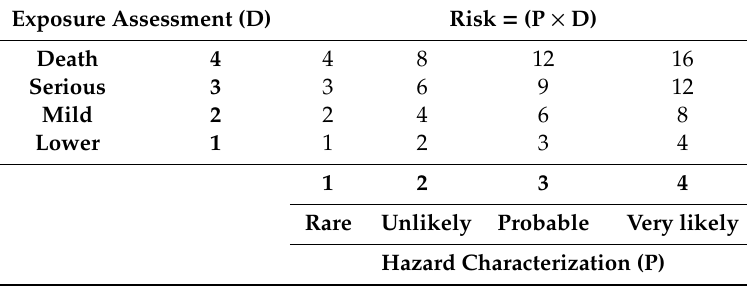
Table A3. Risk characterization (risk score).